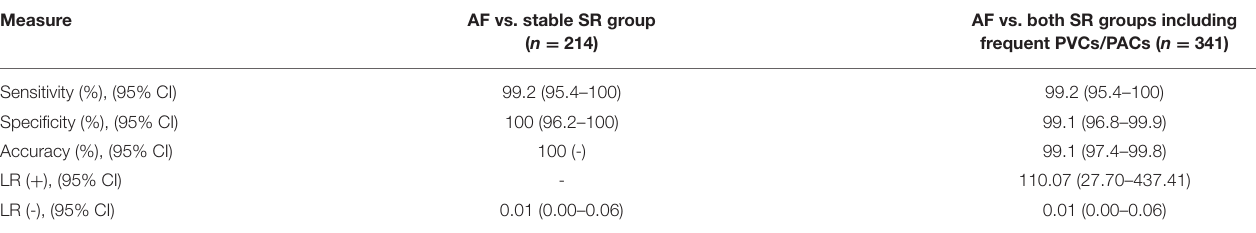
TABLE 3 | Diagnostic measures of the 6-lead ECG of the device for the detection of AF. Measure AF vs. stable SR group